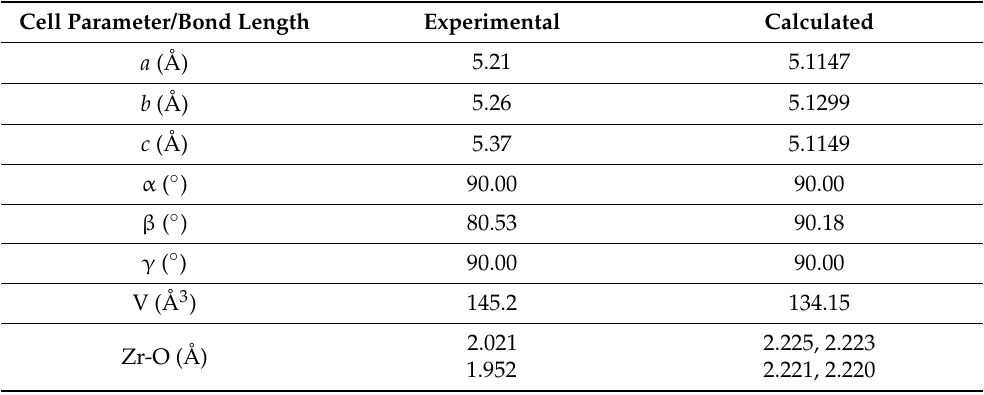
Table 3. Comparison between the experimental and calculated cell parameters and bond distance for bulk m-ZrO 2